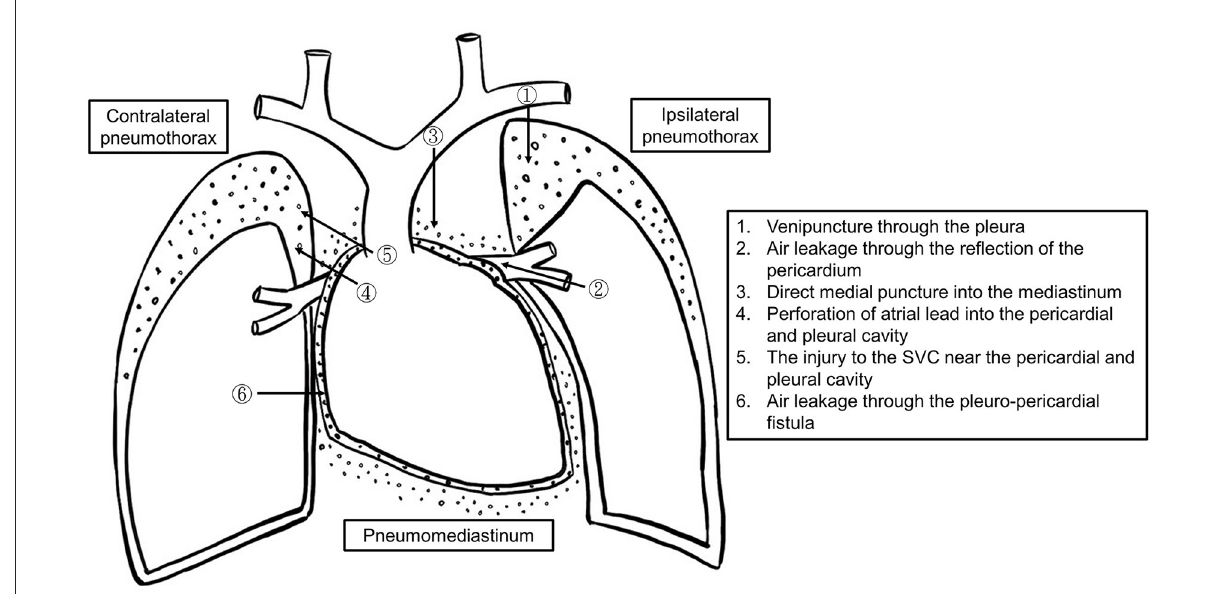
FIGURE2 The schematic diagram of the mechanisms of pneumothorax, pneumopericardium, and pneumomediastinum formation.